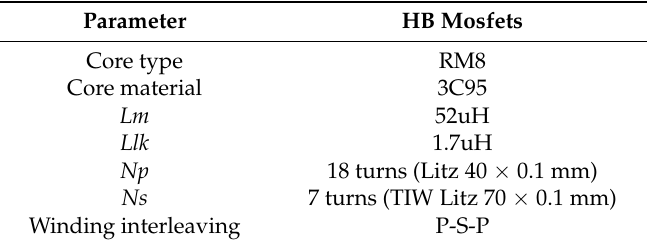
Table 3. Transformer specifications.